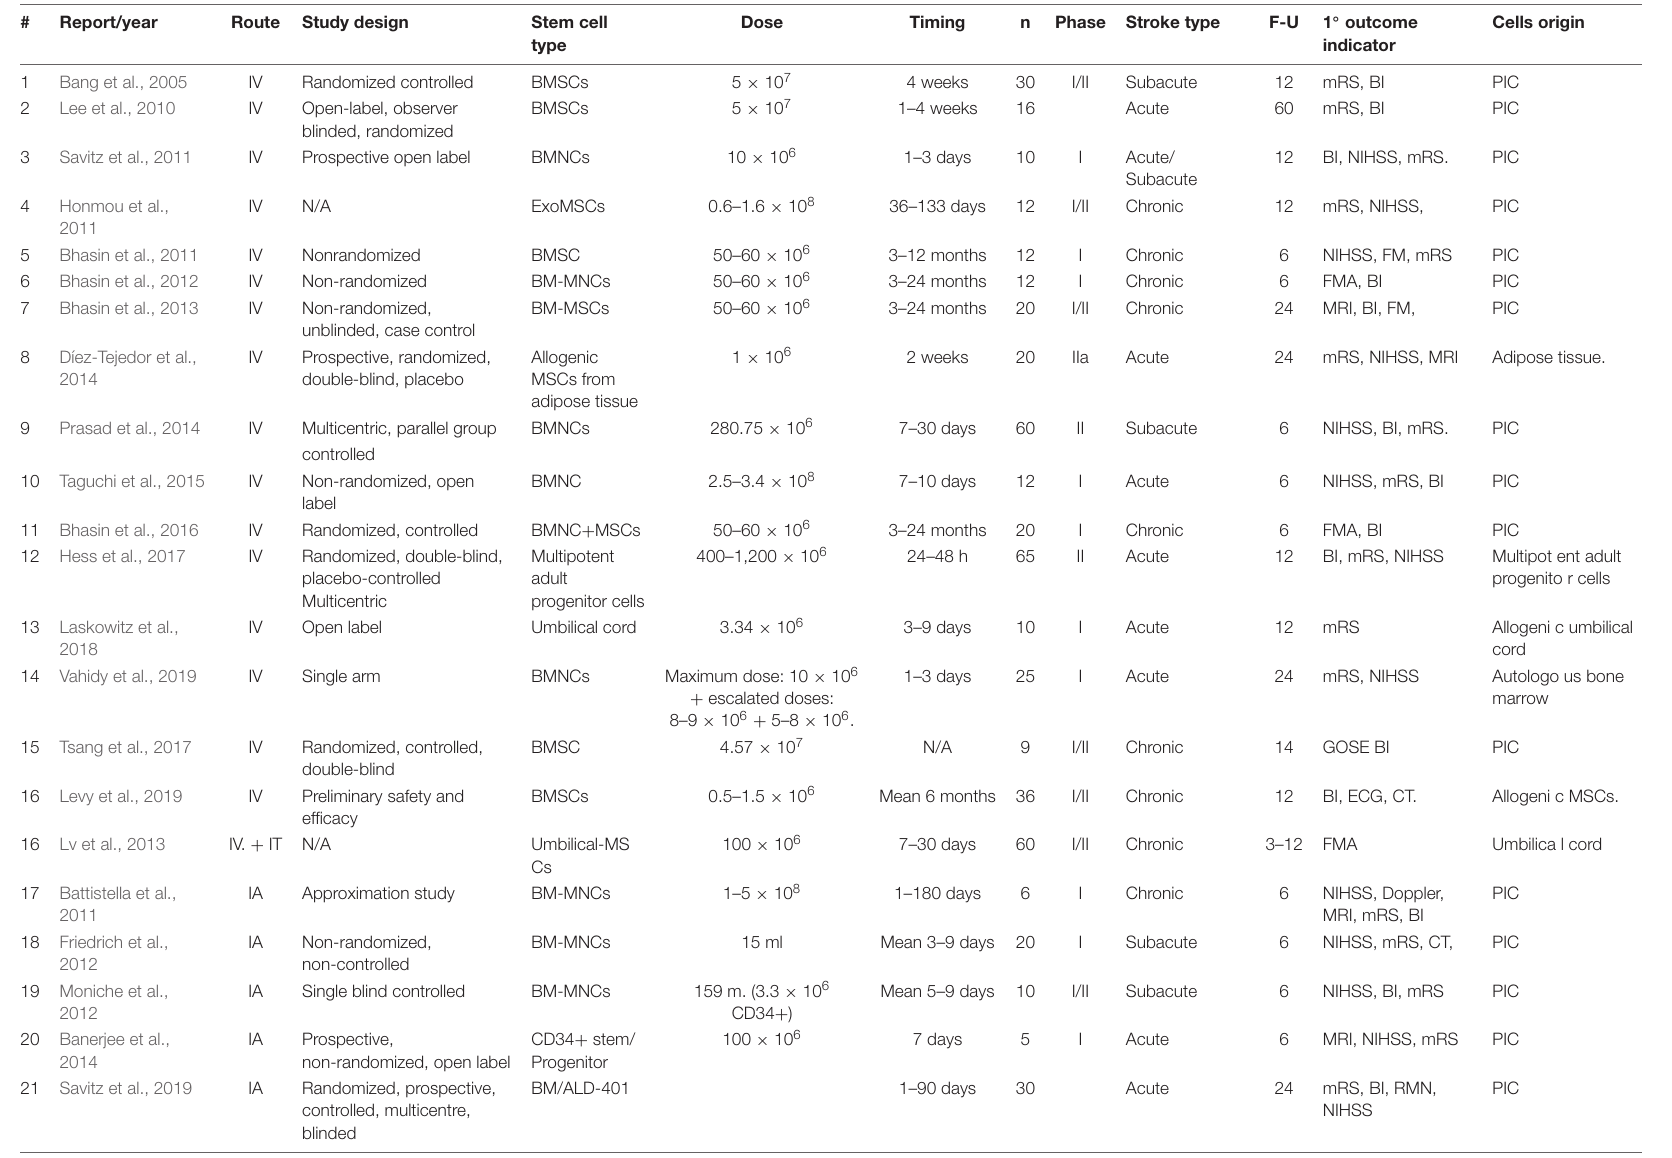
TABLE 1 | Summary of published articles on Stem Cell Therapy in Stroke.